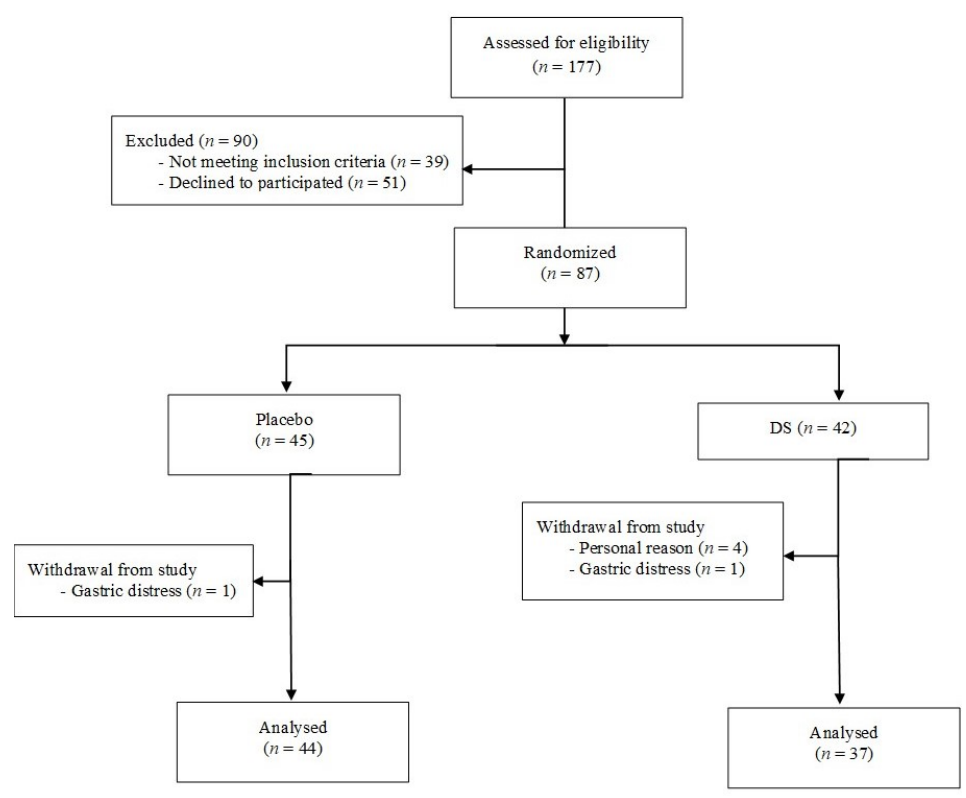
Figure 1. Flow diagram of participants through the study. Baseline characteristics of the patients are shown in Table 1. The mean age of the patients was 62.6 ± 0.8 years, with males representing 63.2% of the participants. The mean BMI was 27.6 ± 0.4. More than half of the subjects (52.9%) had a family history of